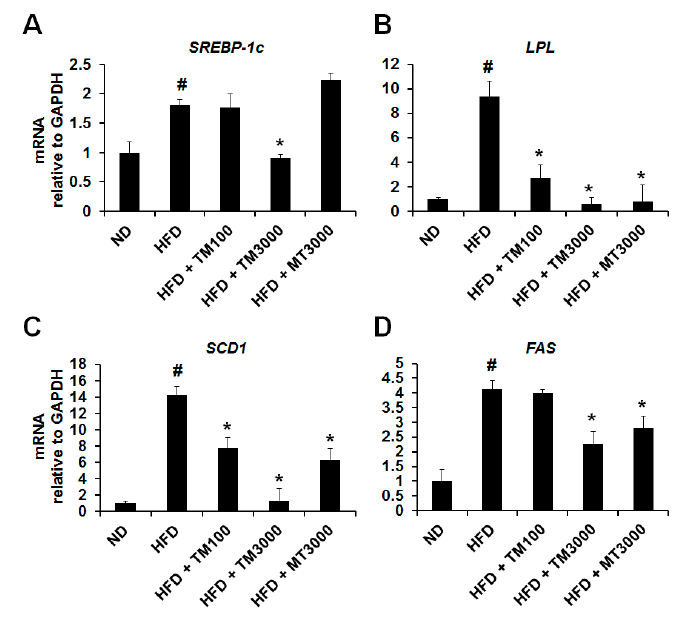
Figure 5. Effect of TML on expression of adipocyte specific markers in vivo. mRNA expression levels of SREBP-1c ( A ), LPL ( B ), SCD1 ( C ), and FAS ( D ) in epididymal adipose tissue were analyzed by real-time PCR. Results are presented as mean ± SD of triplicate. # p -value of <0.05 indicates significant difference from ND. * p -value of <0.05 indicates significant difference from HFD. ND: normal-fat diet; HFD: high-fat diet; HFD + TM100: high-fat diet and 100 mg/kg per day TML; HFD + TM3000: HFD and 3000 mg/kg per day TML; HFD + MT3000: HFD and 3000 mg/kg per day yerba mate (MT). GAPDH : Glyceraldehyde 3-phosphate dehydrogenase.